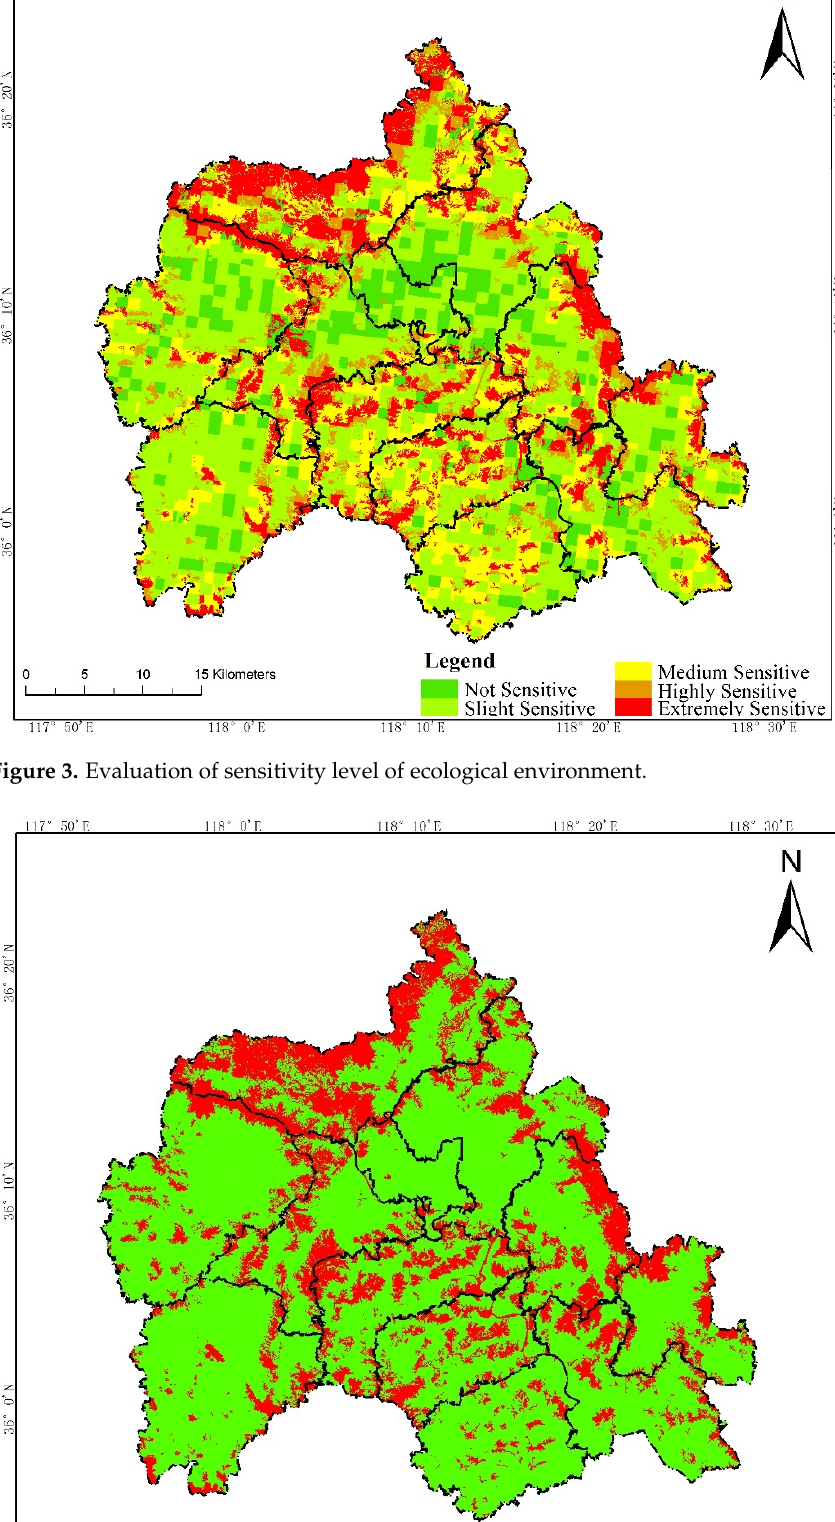
Figure 2. Evaluation of intensity of ecosystem service function.